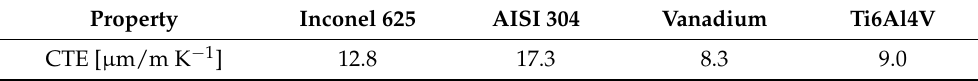
Table 5. Coefficient of thermal expansion of the materials composing the welded plates [42,43]. Property